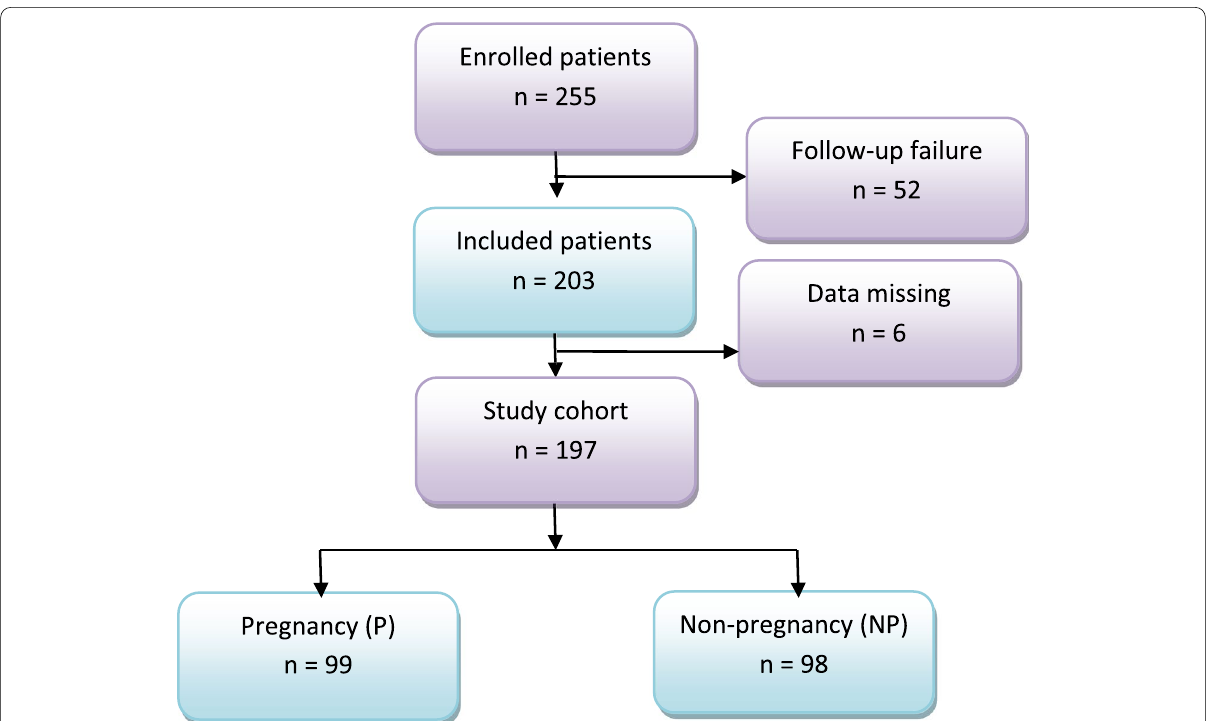
Fig. 2 Flowchart showing the process of patient enrollment. P, pregnancy success after embryo transfer; NP, pregnancy failure after embryo